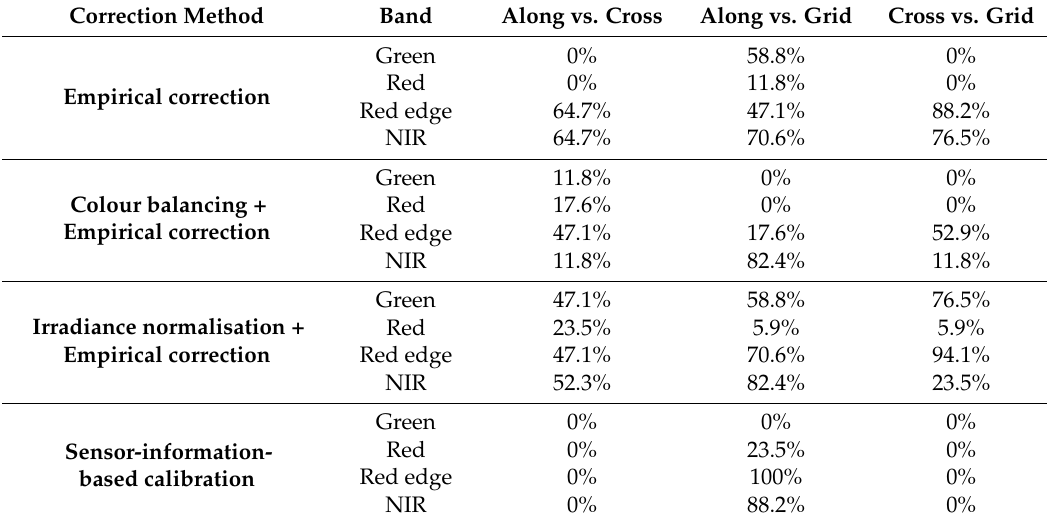
Table A2. Reflectance consistency percentages of tree canopies between different flight patterns in dataset